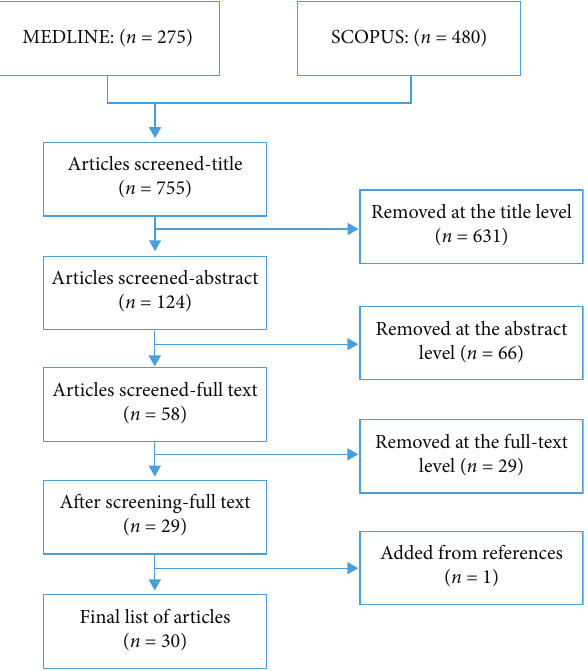
Figure 1: The study selection process using the PRISMA